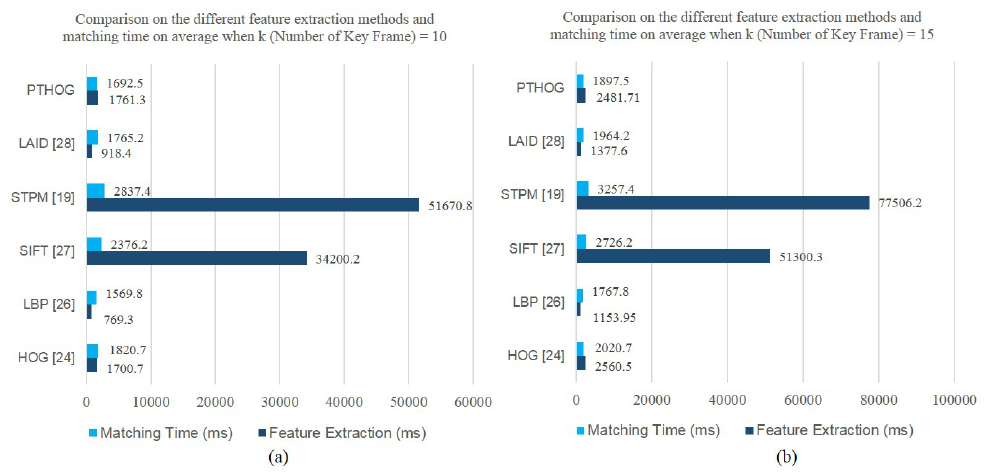
Figure 7. ( a ) Comparison on the different feature extraction methods and matching time on average when k (Number of Key Frame) = 10 and ( b ) Comparison on the different feature extraction methods and matching time on average when k (Number of Key Frame) =